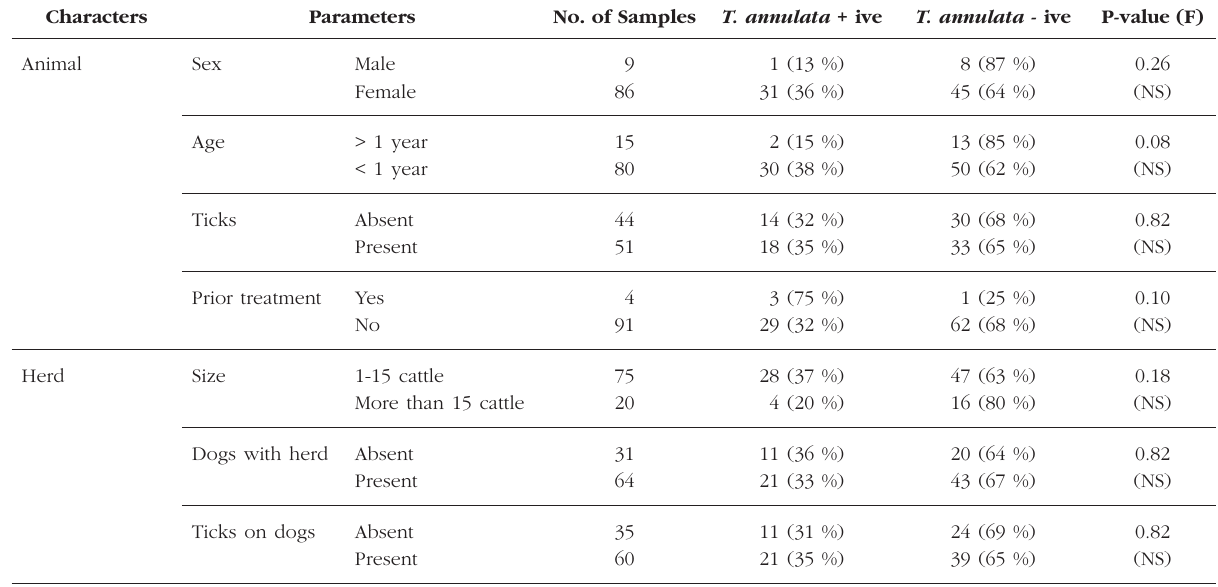
Table II. – Association between parasite prevalence in cattle and the studied parameters describing animal and herd